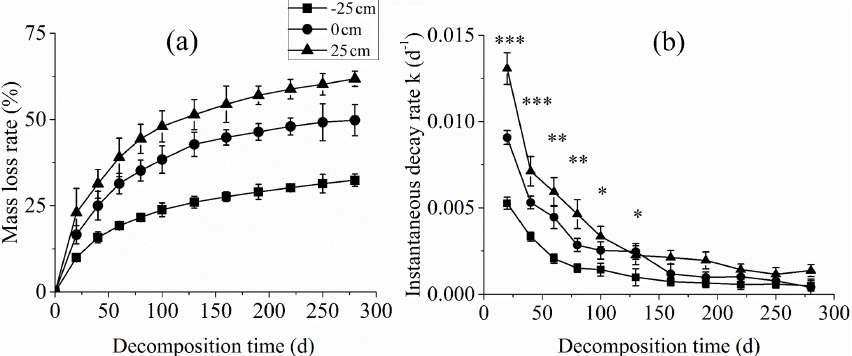
Figure 2. Percentage litter dry weight loss and decomposition rate during C. brevicuspis decomposition at three water levels ( − 25, 0, and + 25cm). *, **, and *** represent significant differences of the litter instantaneous decay rate among the three water levels at the 0.05, 0.01, and 0.001 significance levels, respectively. Table 1. Multiple regression model of instantaneous litter decomposition rate and litter properties. Bold indicates the key factors. Water level